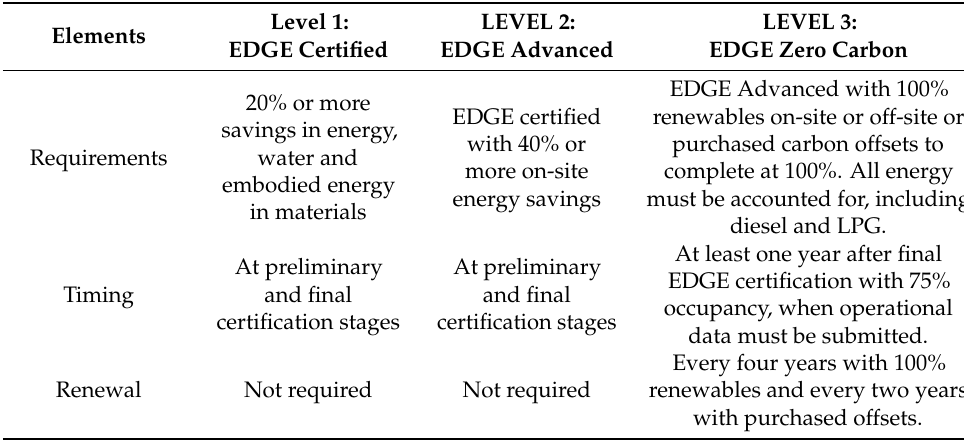
Table 4. Comparison between EDGE’s levels of certification